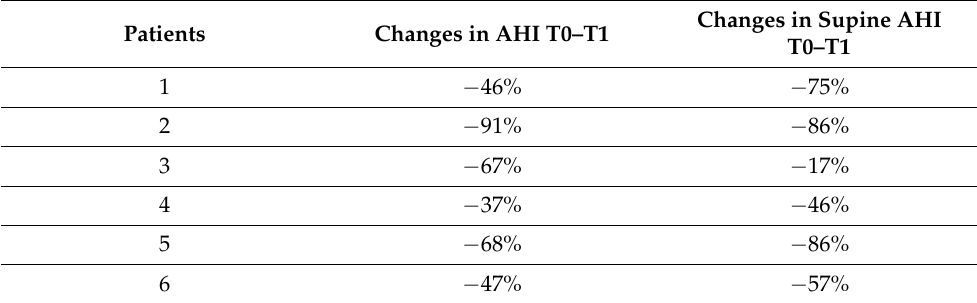
Figure 3. A paired data t-test showed a significant difference between supine AHI recorded at T0 and T1 ( p < 0.05) in patients (PZ) using the OrthoApnea NOA ® device. Regardless of the severity of their OSA, all six patients met the AHI and supine AHI criteria defining treatment success. In supine AHI, they showed reductions ranging from − 17% to − 86% and in AHI from − 37% to − 91% (Table 3). Table 3. Short-term effects of the appliance: changes in AHI and supine AHI.